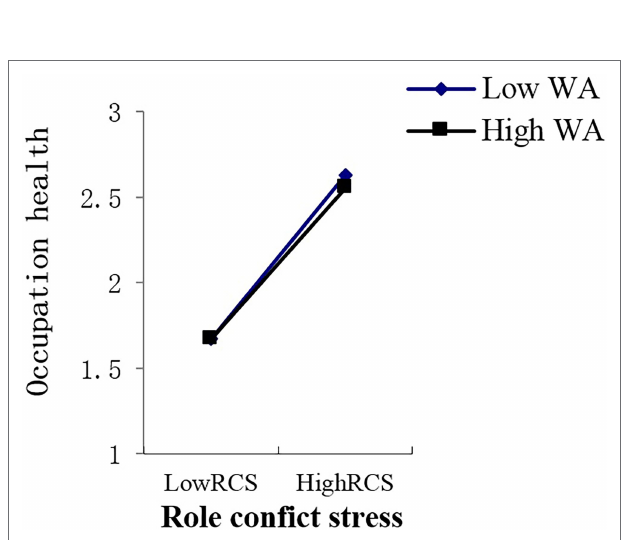
FIGURE 4 | Interactive effects of WA and RCS on OH. WA, work adaptability; RCS, role conflict stress; OH, occupation health.